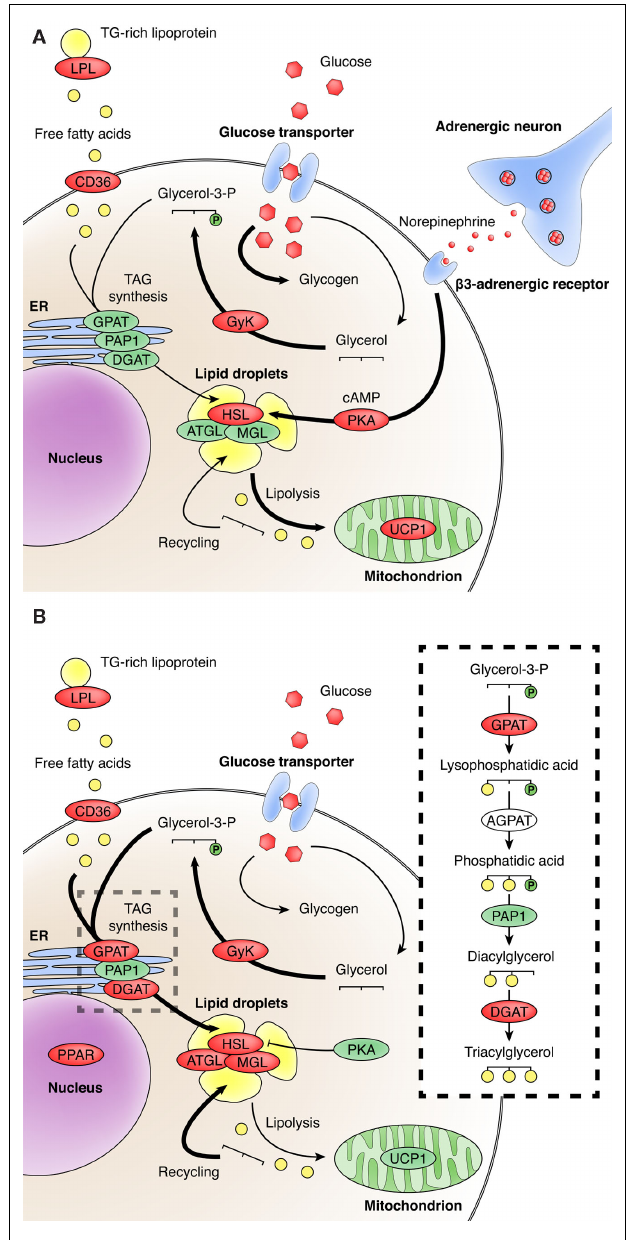
FIGURE 1 | Modulation of brown adipose tissue glucose and lipid metabolism by cold exposure (A) and PPAR γ activation (B). Enzymes in red and pathways with thick arrows are activated in response to corresponding stimulus. Abbreviations: AGPAT, acylglycerol- 3-phosphate-O-acyltransferase; ATGL, adipose triglyceride lipase; CD36, fatty acid translocase; DGAT, diacylglycerol acyltransferase; GPAT, glycerol 3-phosphate acyltransferase; GyK, glycerokinase; HSL, hormone-sensitive lipase; LPL, lipoprotein lipase; MGL, monoacyglycerol lipase; PAP1, phosphatidic acid phosphatase 1; PKA, protein kinase A; UCP1, uncoupling protein 1.